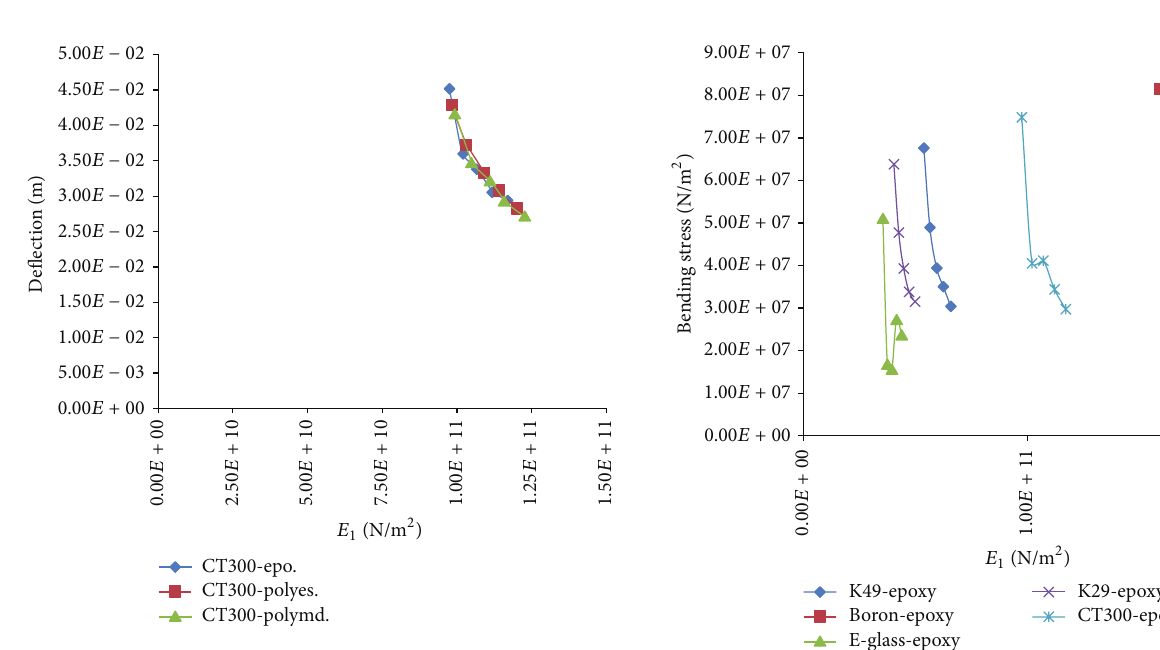
Figure 16: Effect of longitudinal modulus of elasticity on leaf spring deflection of various composite leaf springs based on fiber type.